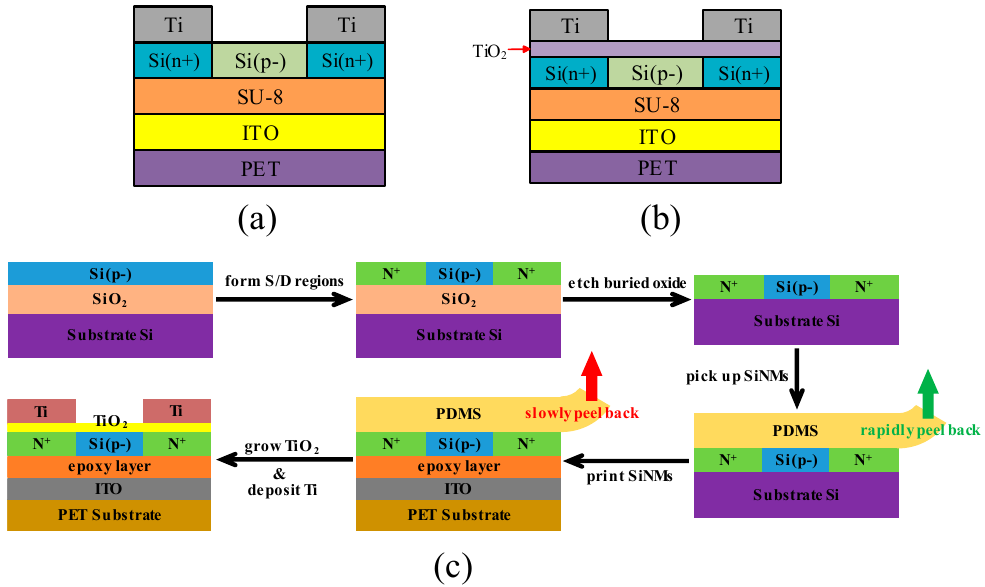
Figure 1. ( a ) Structure schematic of a bendable single crystal silicon TFT without inserting TiO 2 . ( b ) Structure schematic of a bendable single crystal silicon TFT with inserting different cycles of TiO 2 . ( c ) Schematic illustration of fabrication process for bendable single crystal silicon TFT.